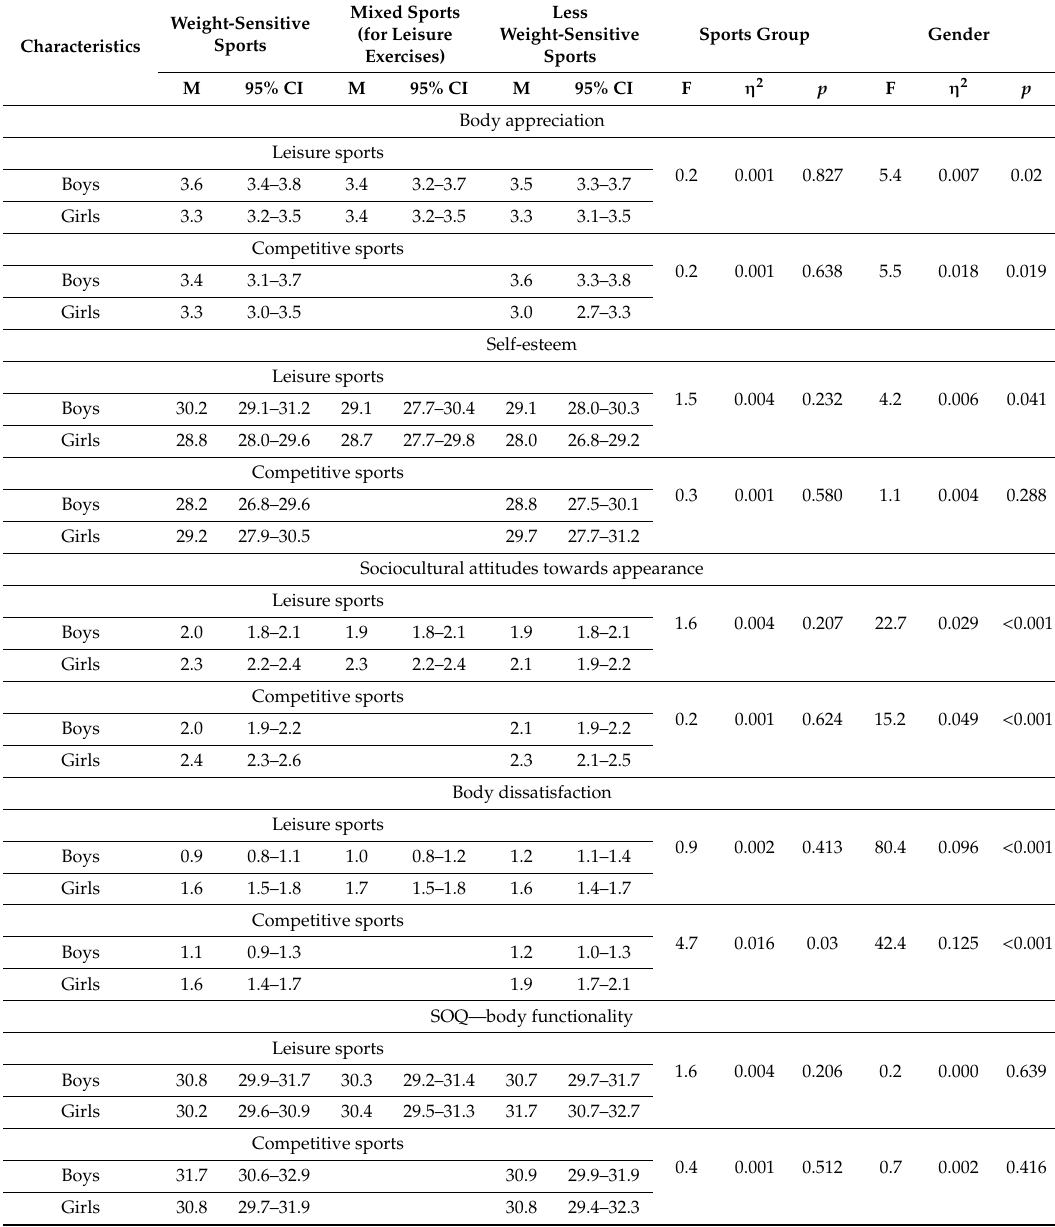
Table 4. Comparison of adolescents’ body image concerns, disordered eating and lifestyle-related factors (mean; 95% CI) across weight-sensitive and less-weight-sensitive sports groups.